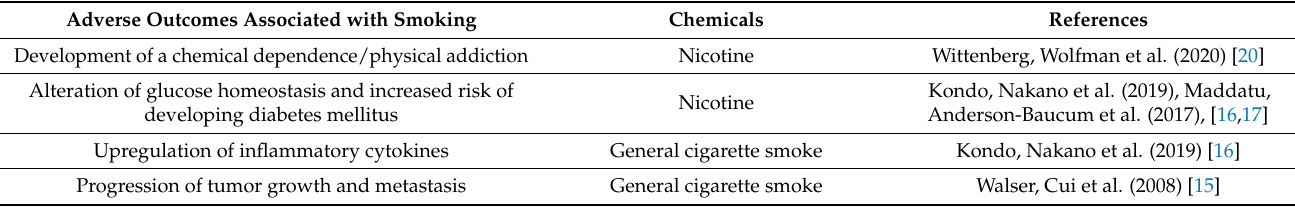
Table 1. Health effects associated with